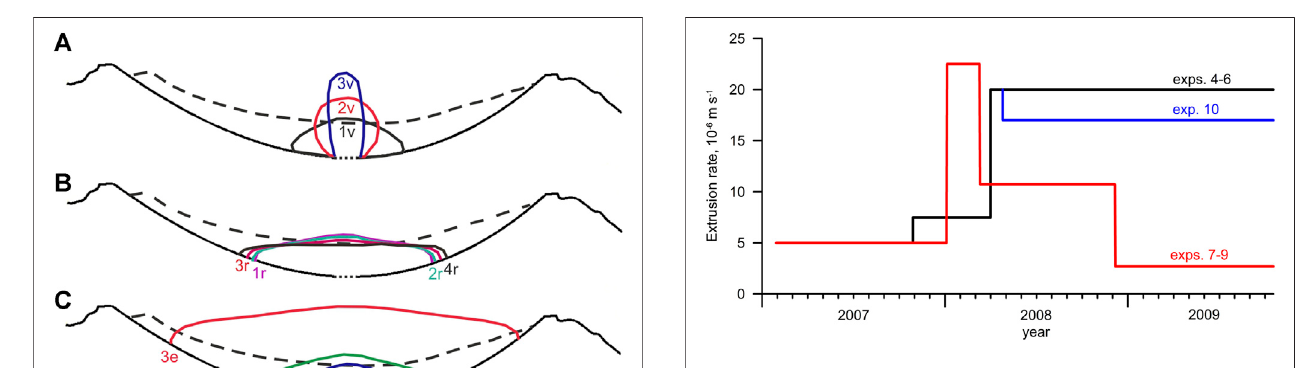
FIGURE 5 | Model extrusion rate in experiments